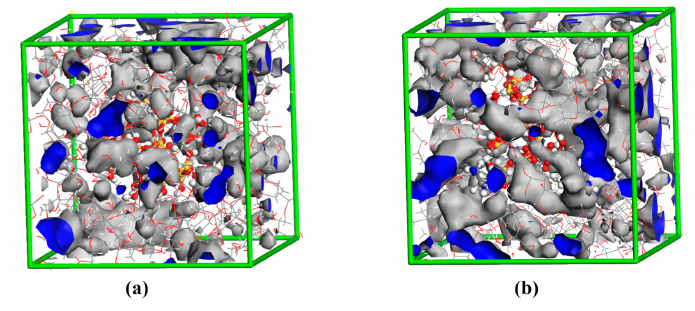
Figure 5. Free volume of the models: ( a ) unmodified model and ( b ) KH792 model. Above all, hydroxyl groups are produced after hydrolysis of silane coupling